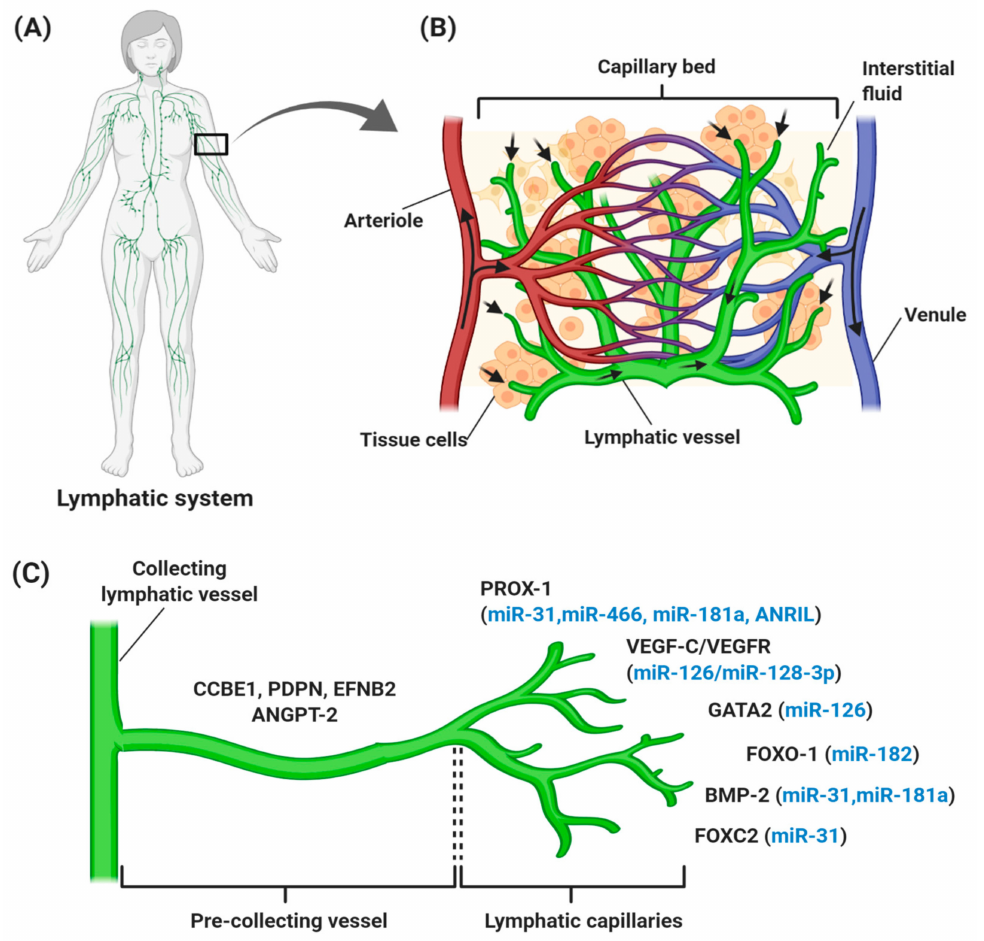
Figure 1. Overview of the human lymphatic structure and developmental lymphangiogenesis. ( A ) An anterior view of the lymphatic system with lymph nodes and vessels. ( B ) Structural relationship of the lymphatic system with the circulatory system, which consists of a capillary bed containing lymphatic vessels intertwined between blood vessels. Blood enters the arteriole (red), is filtered through blood capillaries, and moves into tissue spaces. While most of the interstitial fluid moves back into the venule (blue), some of them drain into lymphatic capillaries to become lymph and proceed to lymph nodes. ( C ) Lymphangiogenesis under physiological conditions with specific genes and lymphangiogenic factors that regulate the process. Vascular endothelial growth factor receptor (VEGFR-3) becomes more restricted to lymphatic endothelial cell (LEC) precursors and starts to express neuropilin-2 (NRP-2), increasing the sensitization of LEC towards VEGF-C, which subsequently stimulates VEGF-C / VEGFR-3 signaling to induce the lateral budding of LEC and lymphatic sprouting. VEGF-C / VEGFR-3 signaling continuously upregulates additional LEC markers, such as forkhead box 1 and C2 (FOXO1 and FOXC2), podoplanin (PDPN), angiopoietin-2 (ANGPT-2), ephrin B2 (EFNB2), bone morphogenesis protein-2 (BMP-2), and GATA-binding protein 2 (GATA2), which are involved in developmental lymphangiogenesis, including vessel sprouting, lymphatic maturation, and the remodeling of lymphatic vasculature. The lymphangiogenic factors expressed throughout the process are also regulated by di ff erent ncRNAs (blue). It is common for miRNAs to regulate more than one gene, thereby explaining the expression of miR-126, miR-181a, and miR-31 at di ff erent stages of lymphatic